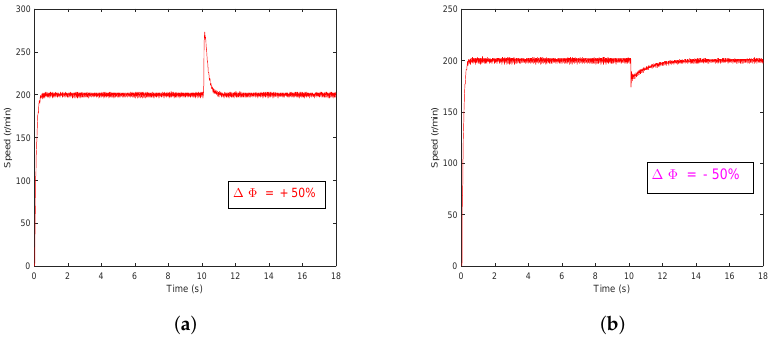
Figure 13. Speed response curves under GPC+ESO method with a sudden change of rotor flux value. ( a ) ∆Φ = + 50%; ( b ) ∆Φ = − 50%.